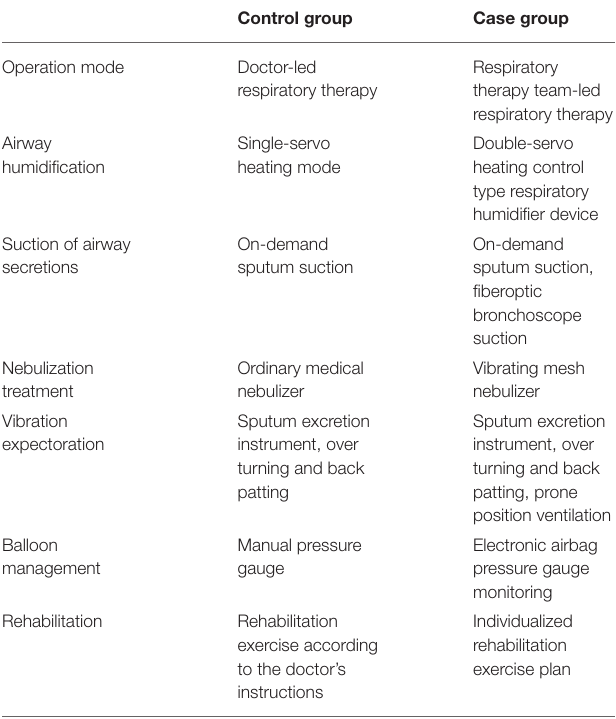
TABLE 1 | Comparison of nursing plans between the two groups.